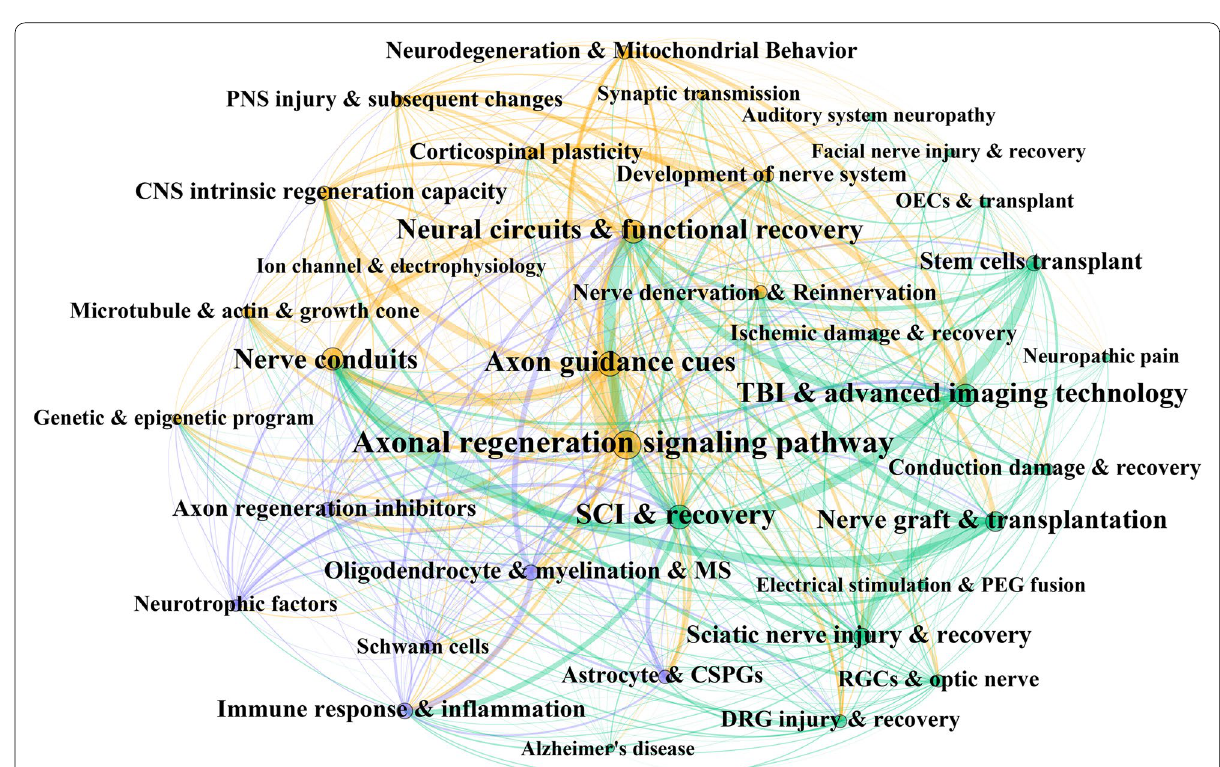
Fig. 9 The network analysis of the research topics. The yellow cluster represents the “neuron intrinsic regeneration mechanisms,” the purple cluster represents the “non-neuron cells and factors” cluster, and the green cluster represents the “diseases/disease models and techniques”